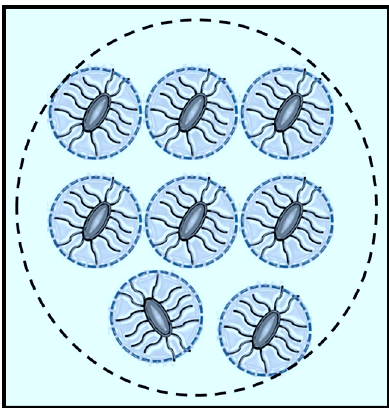
Figure 4. Cluster of asphaltene nanoaggregates.